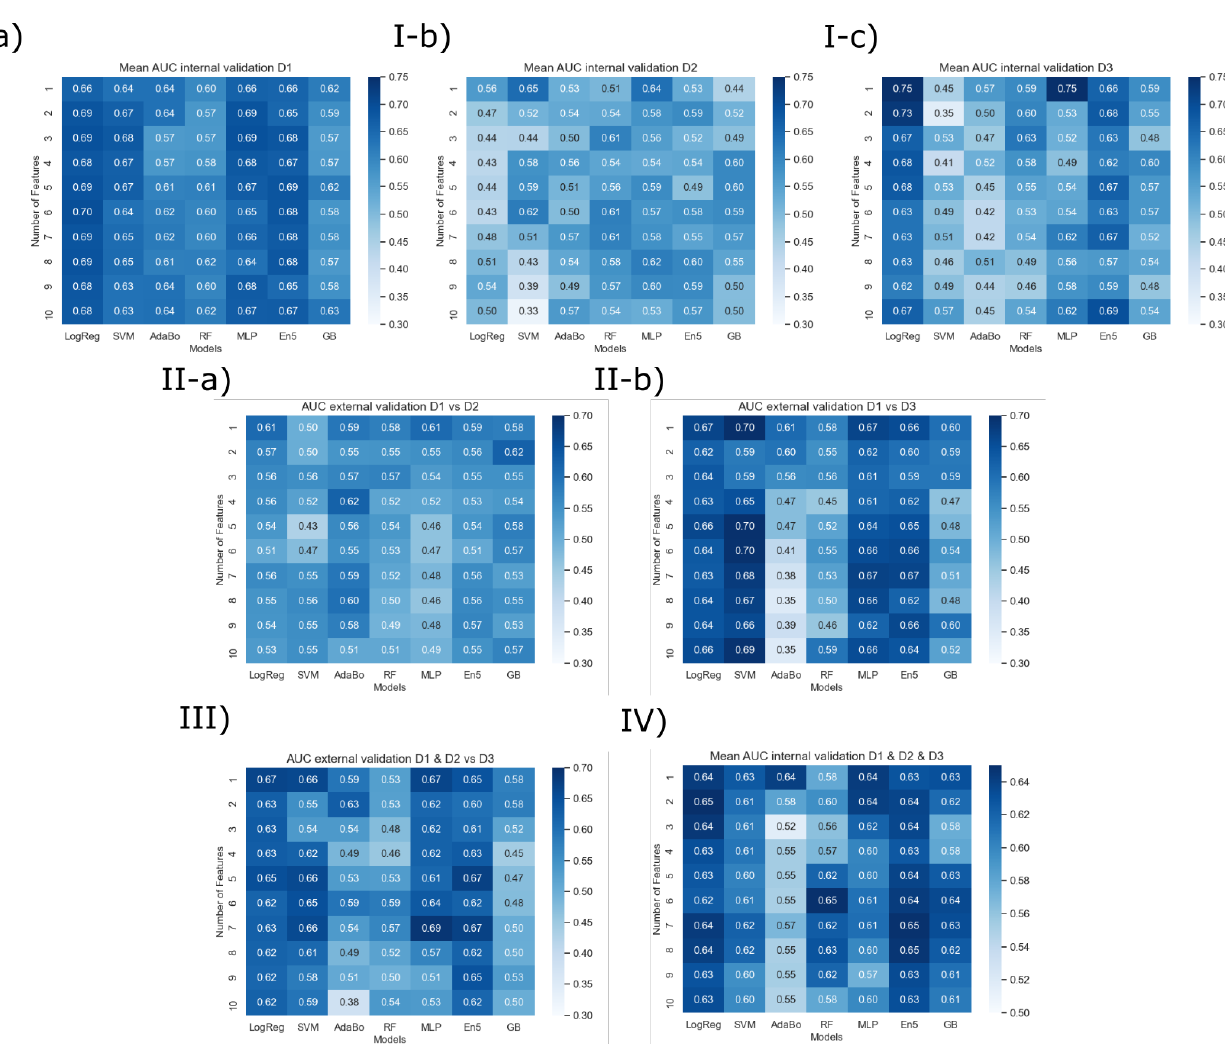
Figure 7. Heatmaps with AUC for all the experimental setups. ( I-a , I-b , I-c ) Heatmaps with mean AUC of internal cross-validation from experiment 1 for D1, D2, and D3, respectively. ( II-a , II-b ) AUC of external validation, from experiment 2, on D2 and D3, respectively. ( III ) AUC of external validation, from experiment 3, on D3. ( IV ) Mean internal cross-validation AUC from experiment 4 on D1, D2, and D3 considered as a single